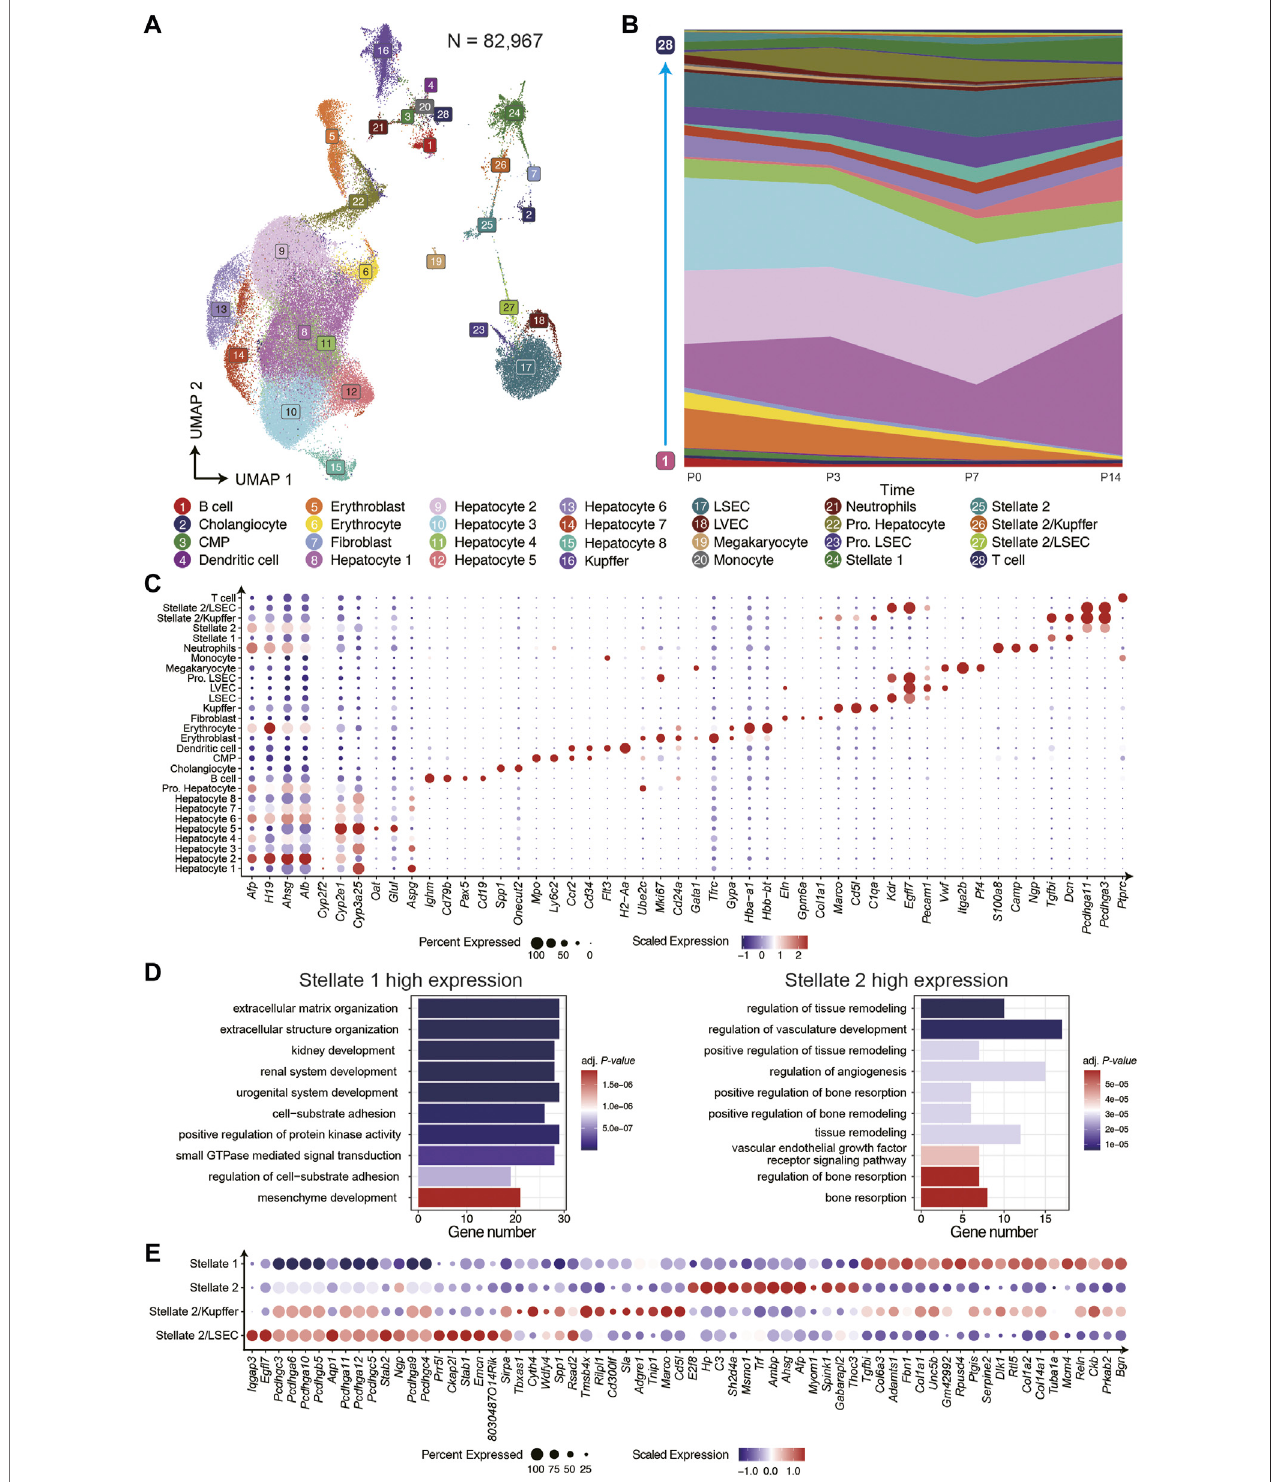
FIGURE 2 | The cell type composition of postnatal liver development. (A) The UMAP of snRNA-seq data displayed 28 clusters in four time points. (B) The cell composition was dynamic at four time points. (C) The dot plot for cell-type-speci fi c genes expression in 28 clusters. (D) The GO term enrichment analysis of differential genes of two hepatic stellate clusters. (E) Highly expressed genes in hepatic stellate cell subtypes